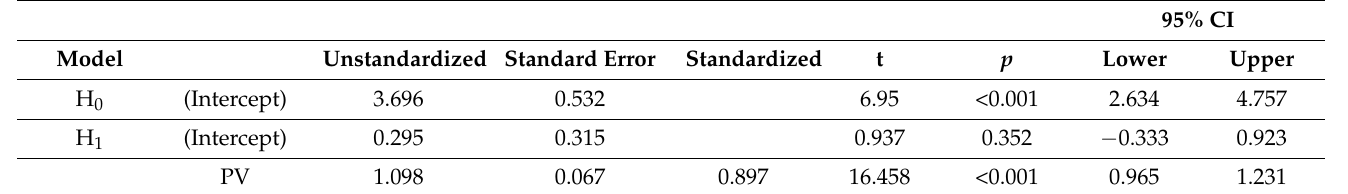
Table 15. Horizontal dry plate method and wet candle method—coefficient of linear regression analysis.